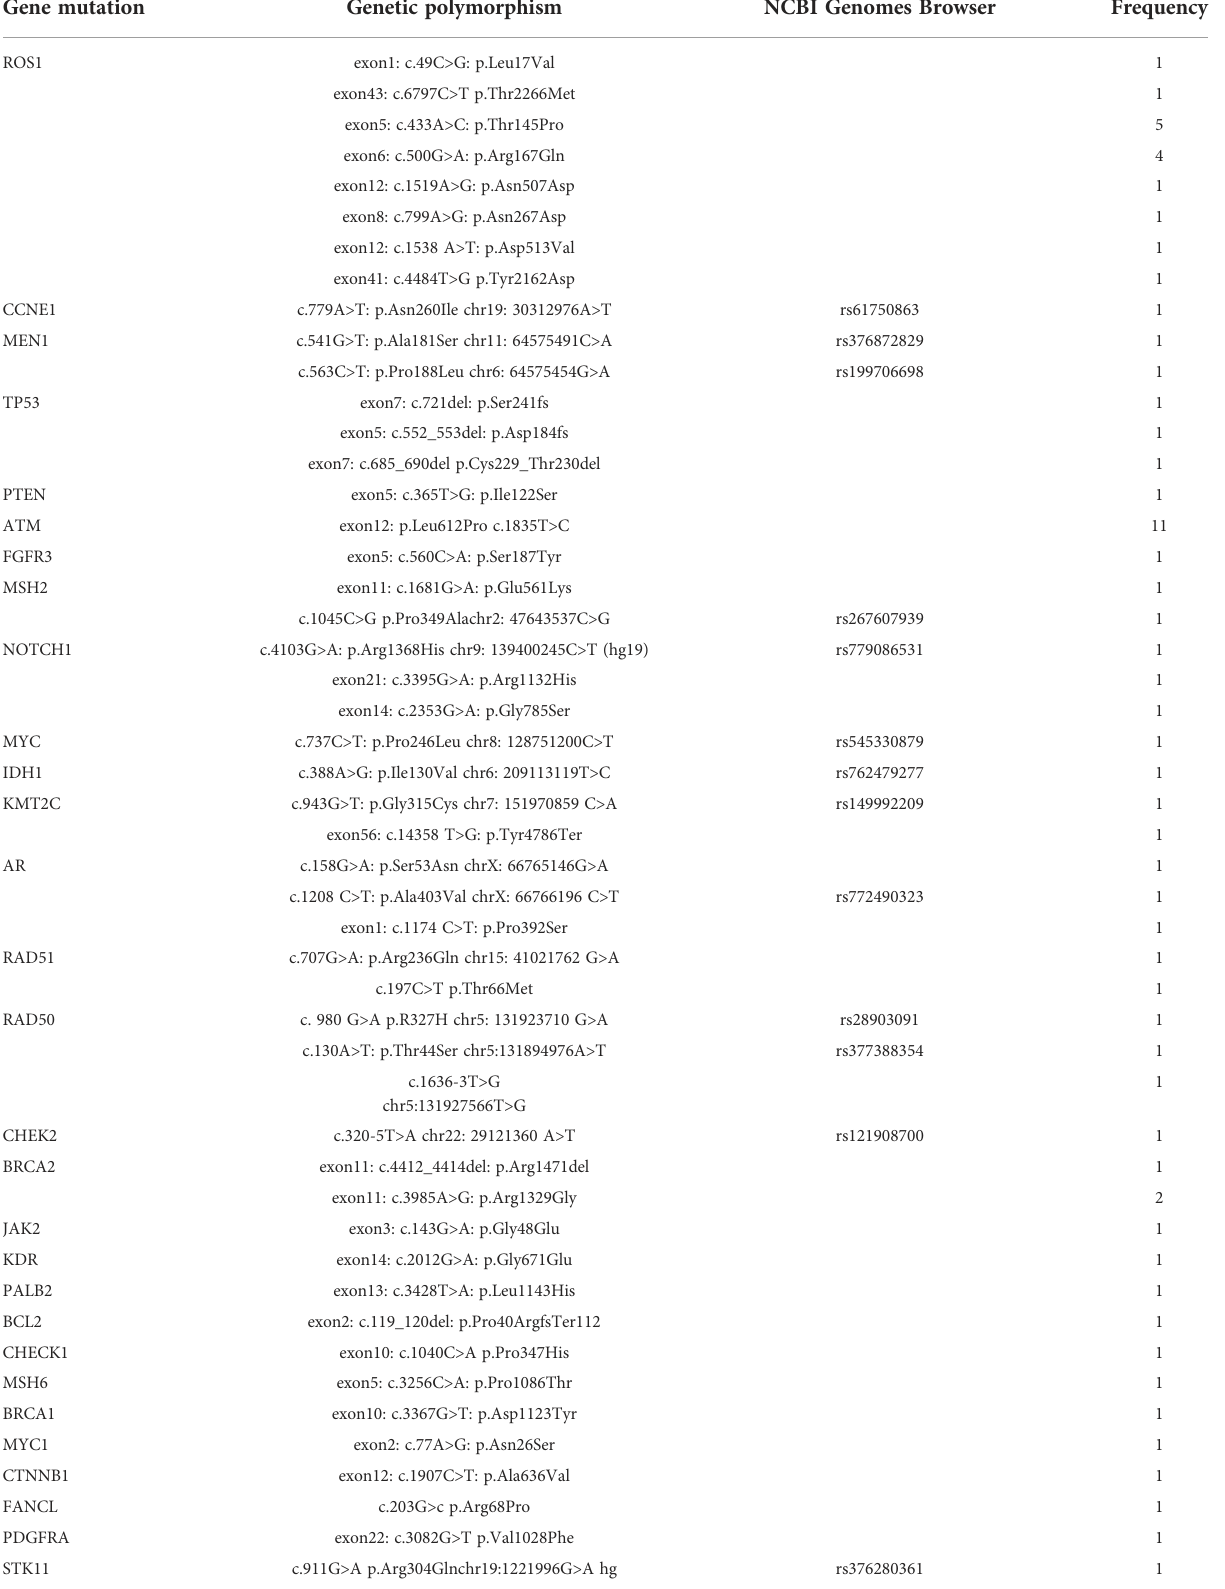
TABLE 2 Somatic mutations of uncertain signi fi cance (VUS) identi fi ed in patients with HGSC. Gene mutation